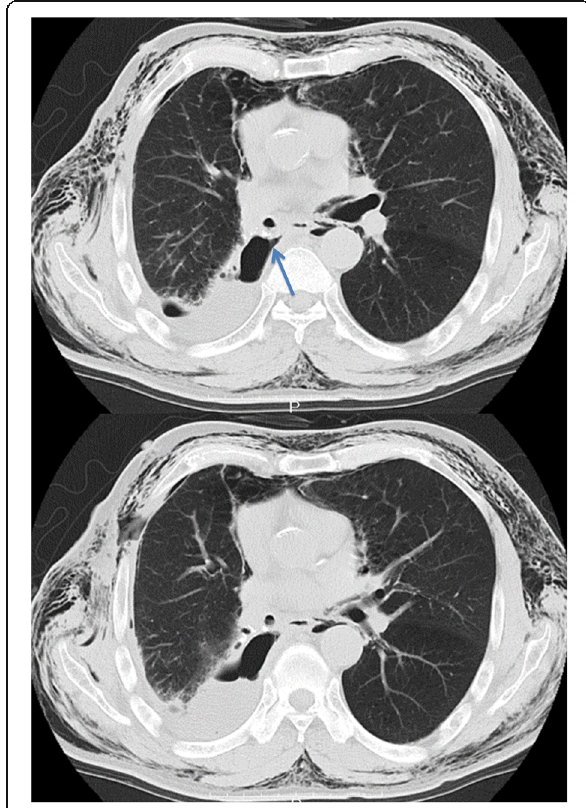
Fig. 1 CT image before re-operation, on POD 12 following the primary operation (i.e., right lower lobectomy). The arrow shows the broken appearance of the bronchial stump. CT computed tomography, POD postoperative